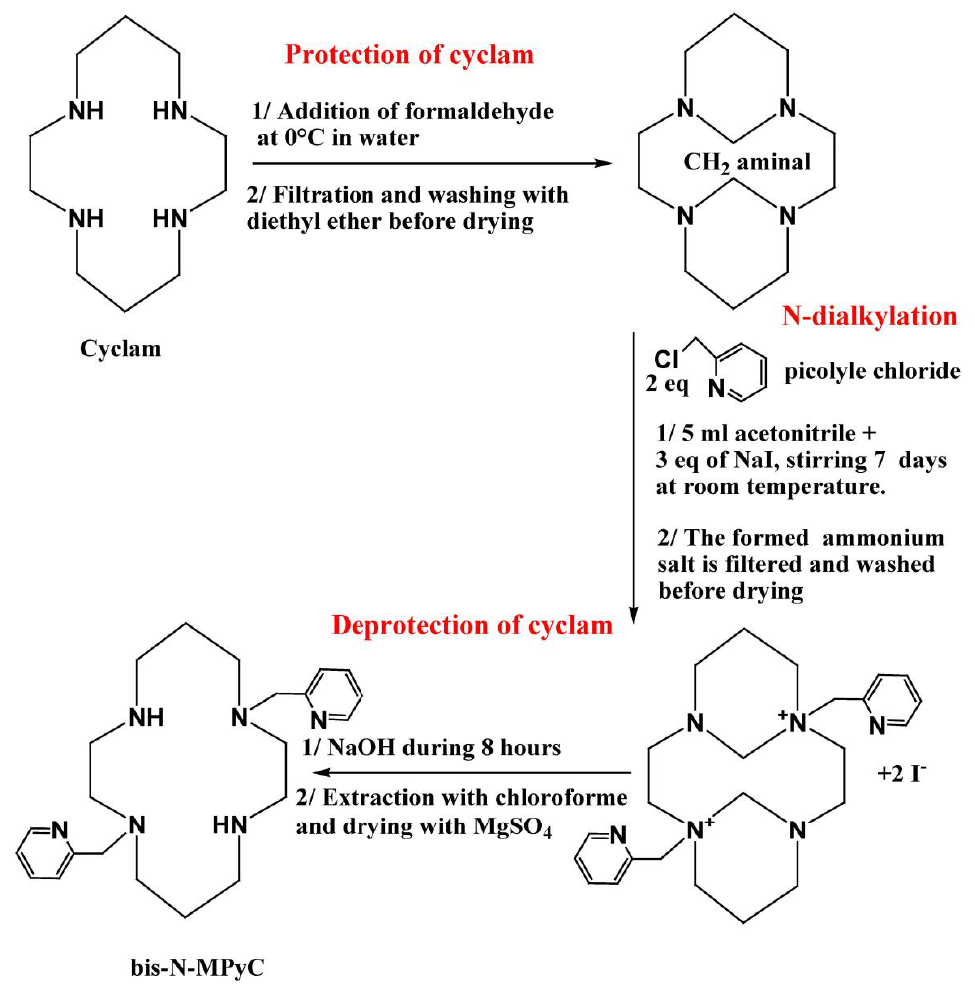
Figure 1. The synthesis of di-N-alkylated systems from